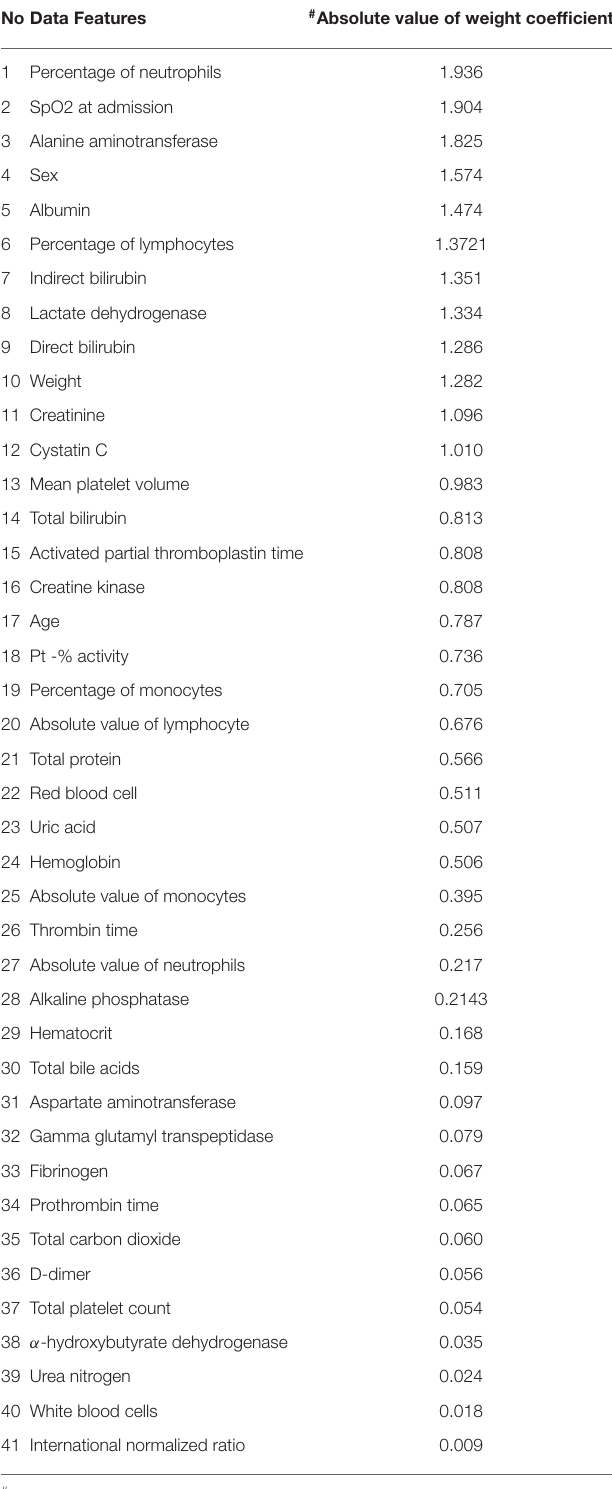
TABLE 4 | The results of model training based on the features of COVID-19 patients including age, sex, and height in Leishenshan Hospital, China. No Data